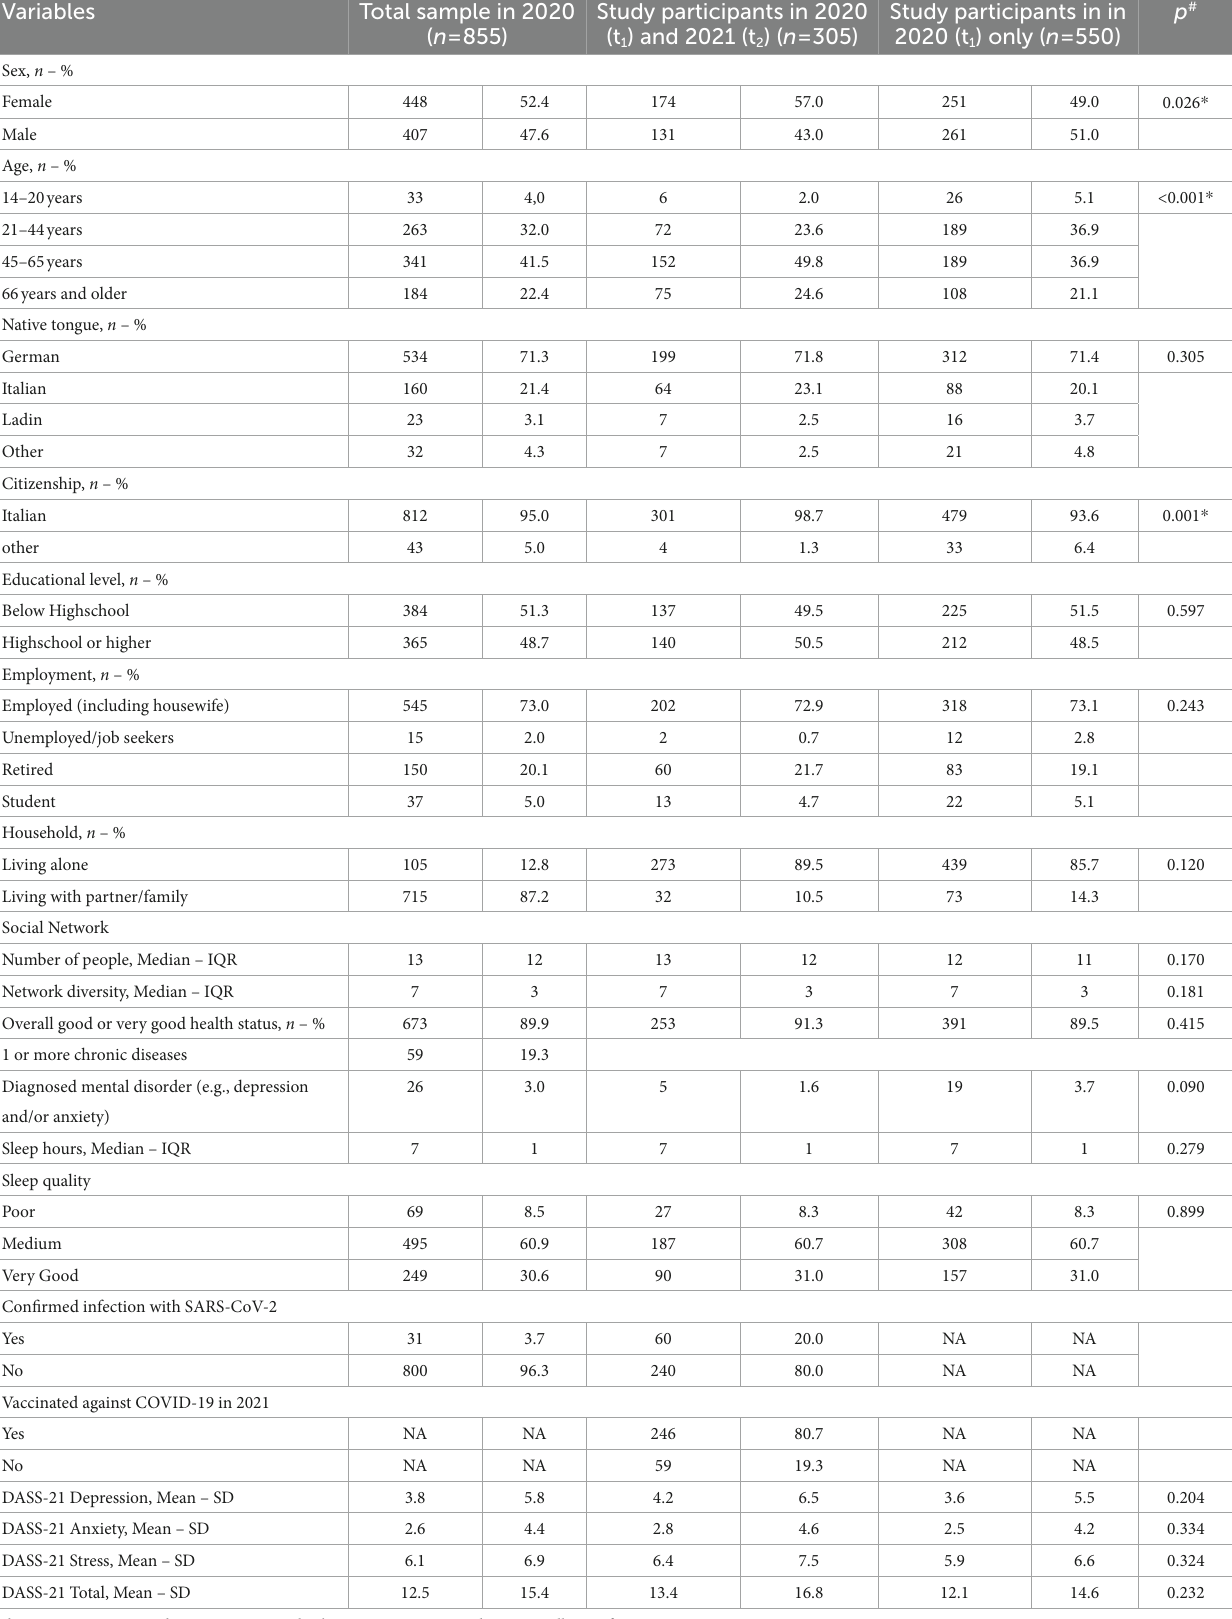
TABLE 1 Characteristics of study participants in 2020 ( n = 855) and comparison between study participants in 2020 (t 1 ) and 2021 (t 2 ) ( n = 305) and study participants in 2020 (t 1 ) only ( n =